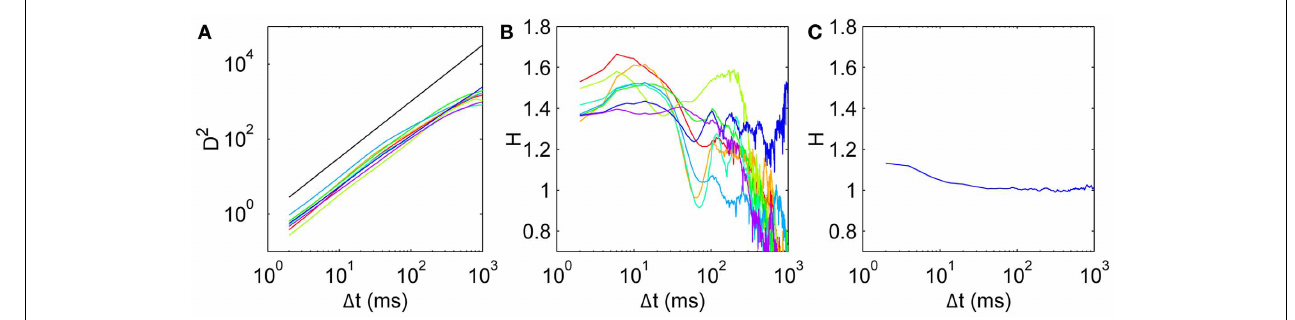
FIGURE 3 | Mean squared displacement and scaling exponent for all subjects. (A) D 2 , with a reference line (black) with slope H = 1 . 5. (B) Scaling exponent H for mean square displacement given by the gradients of the D 2